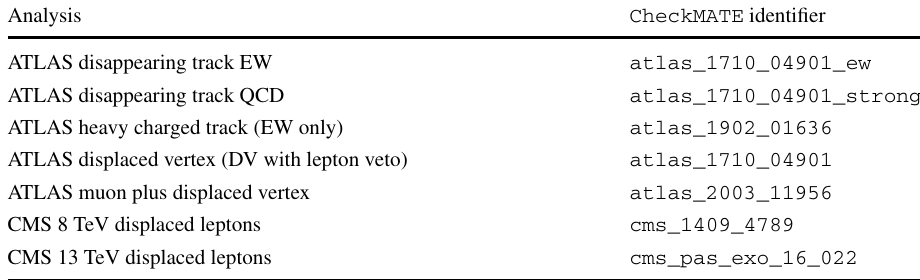
Table 4 Table of implemented LLP analyses and their identifiers that can be used in the CheckMATE run